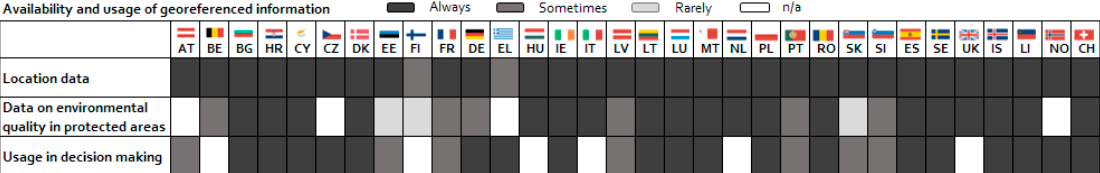
Figure 5. Availability and usage of georeferenced information on location and environmental quality in 32 European countries (EU28 and Iceland, Liechtenstein, Norway and Switzerland).